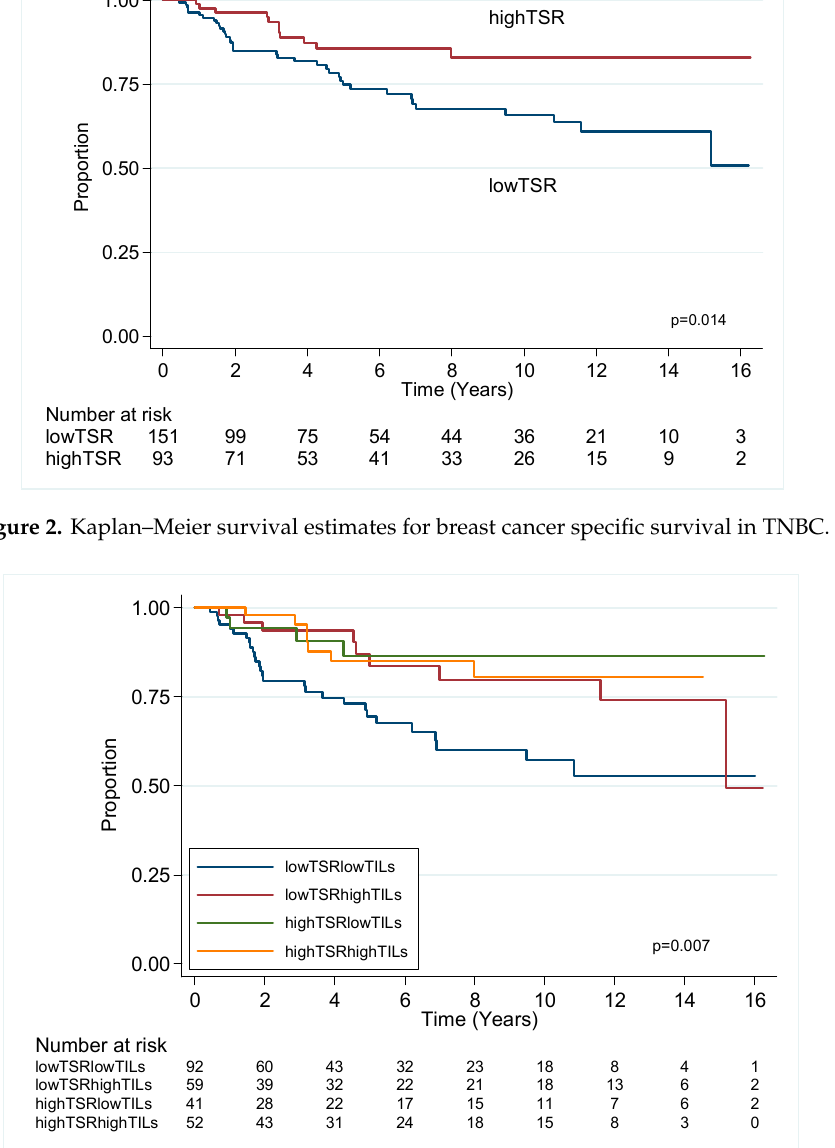
Table 2. Univariate and multivariate analysis for OS and BCSS in luminal ER+ breast cancer.